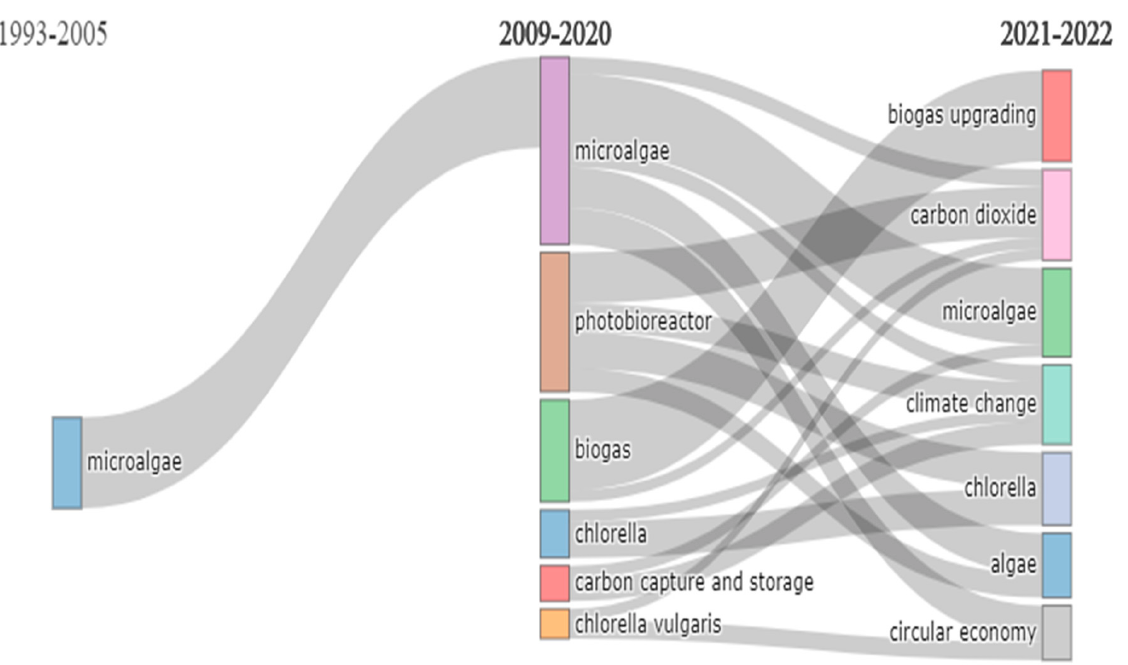
Molecules 2022 , 27 , x FOR PEER REVIEW Figure 2. Map of thematic evolution of keywords on CO 2 capture with microalgae (Bibliometrix). Figure 2. Map of thematic evolution of keywords on CO